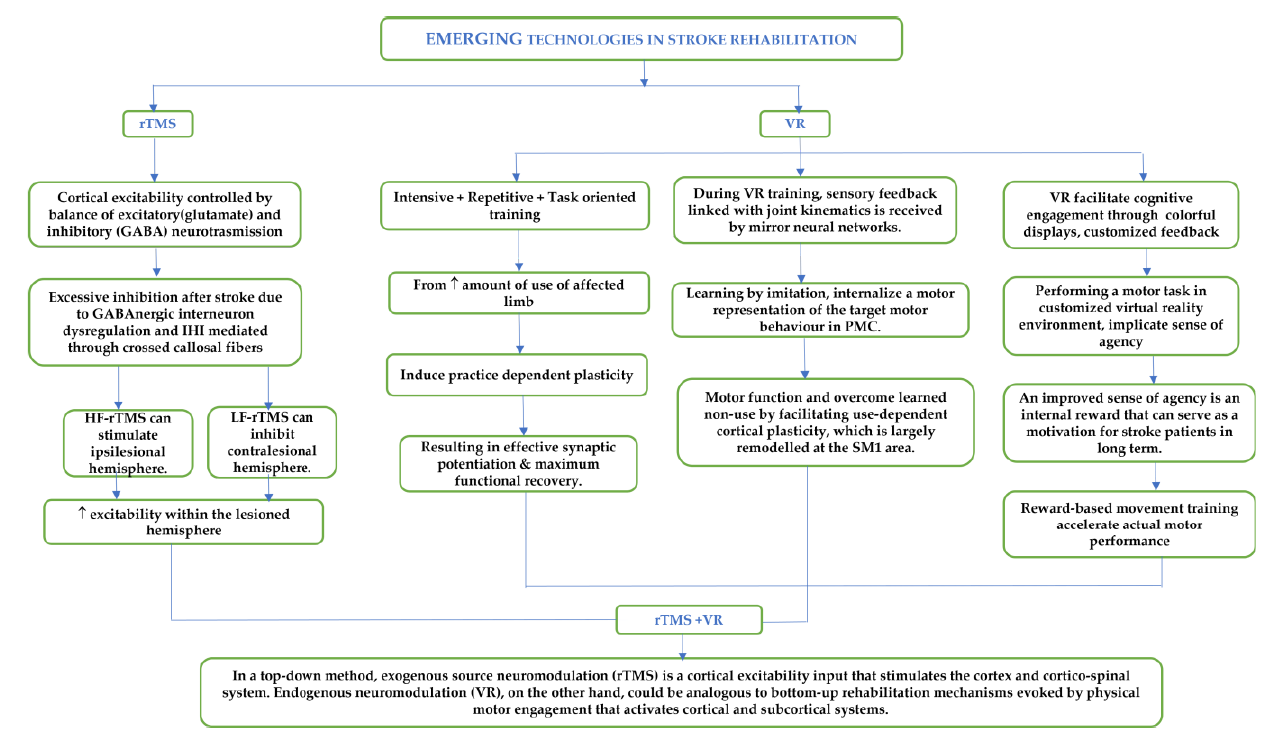
Figure 1. Combined neurophysiological effects of VR and rTMS. HF: High Frequency; LF: Low Frequency; PMC: Primary Motor Cortex; rTMS: Repetitive Magnetic Stimulation; SMC: Primary Sensorimotor Cortex; VR: Virtual Reality.